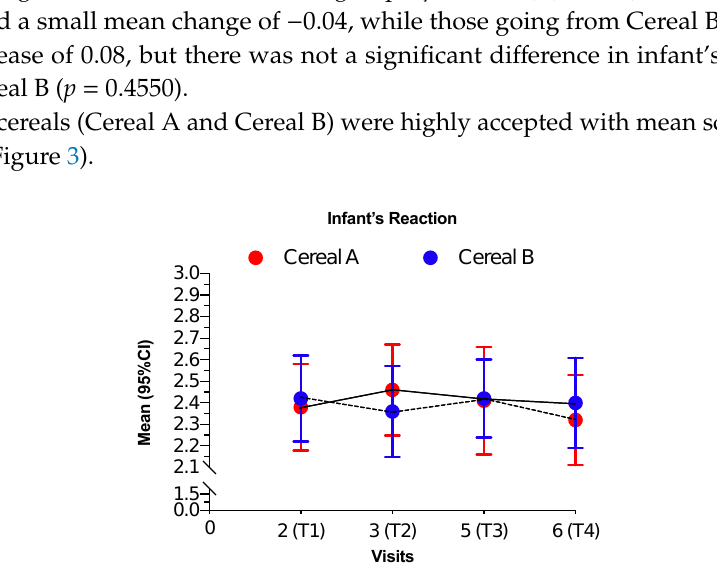
Figure 3. Scores for infant’s reaction in each visit for both intervention groups. Scale—0 = very negative, 1 = negative, 2 = positive, 3 = very positive. Values are shown as mean and 95% confidence intervals. Continuous line represents the intervention group AB and the discontinuous line represents the intervention group BA. Cereal A—0% whole grain and 24 g/100 g sugar; Cereal B—50% whole grain and 12 g/100 g sugars.